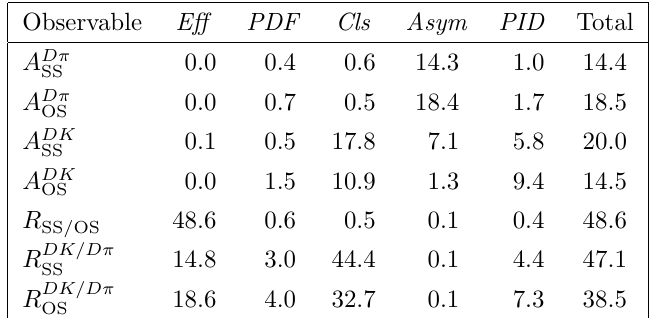
Figure 4 . Invariant mass of SS B (cid:6) components are detailed in the legend of (cid:12)gure 2.